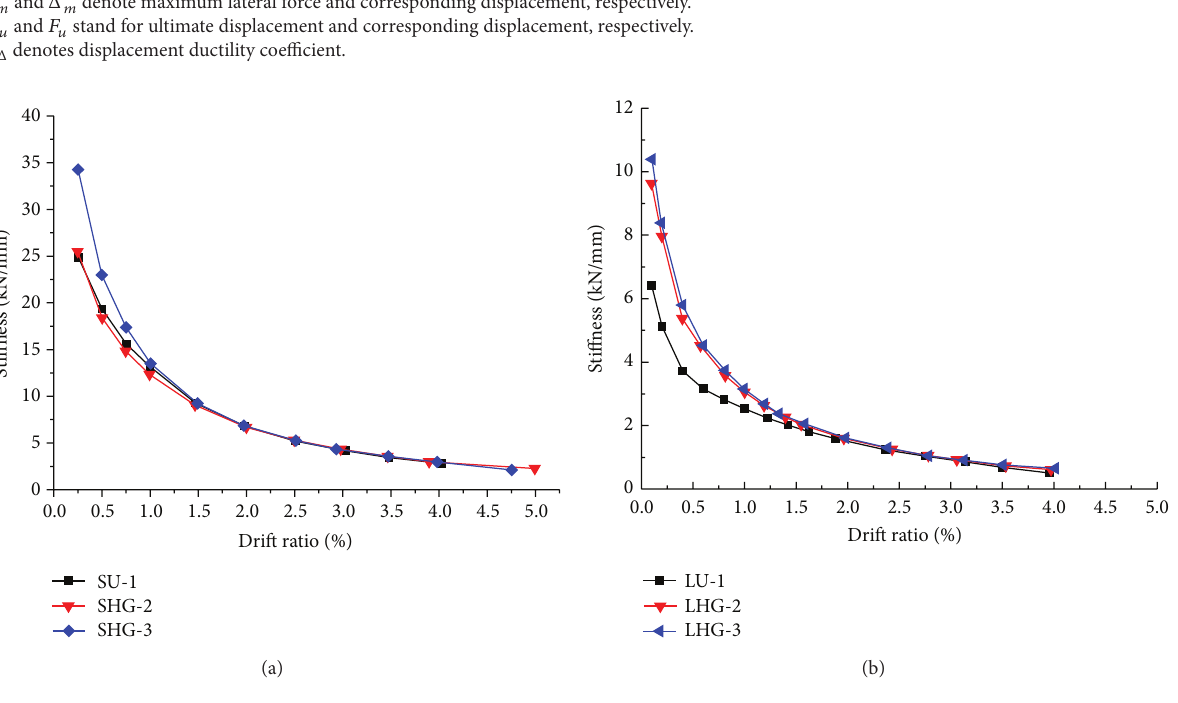
Figure 6: Curves of stiffness